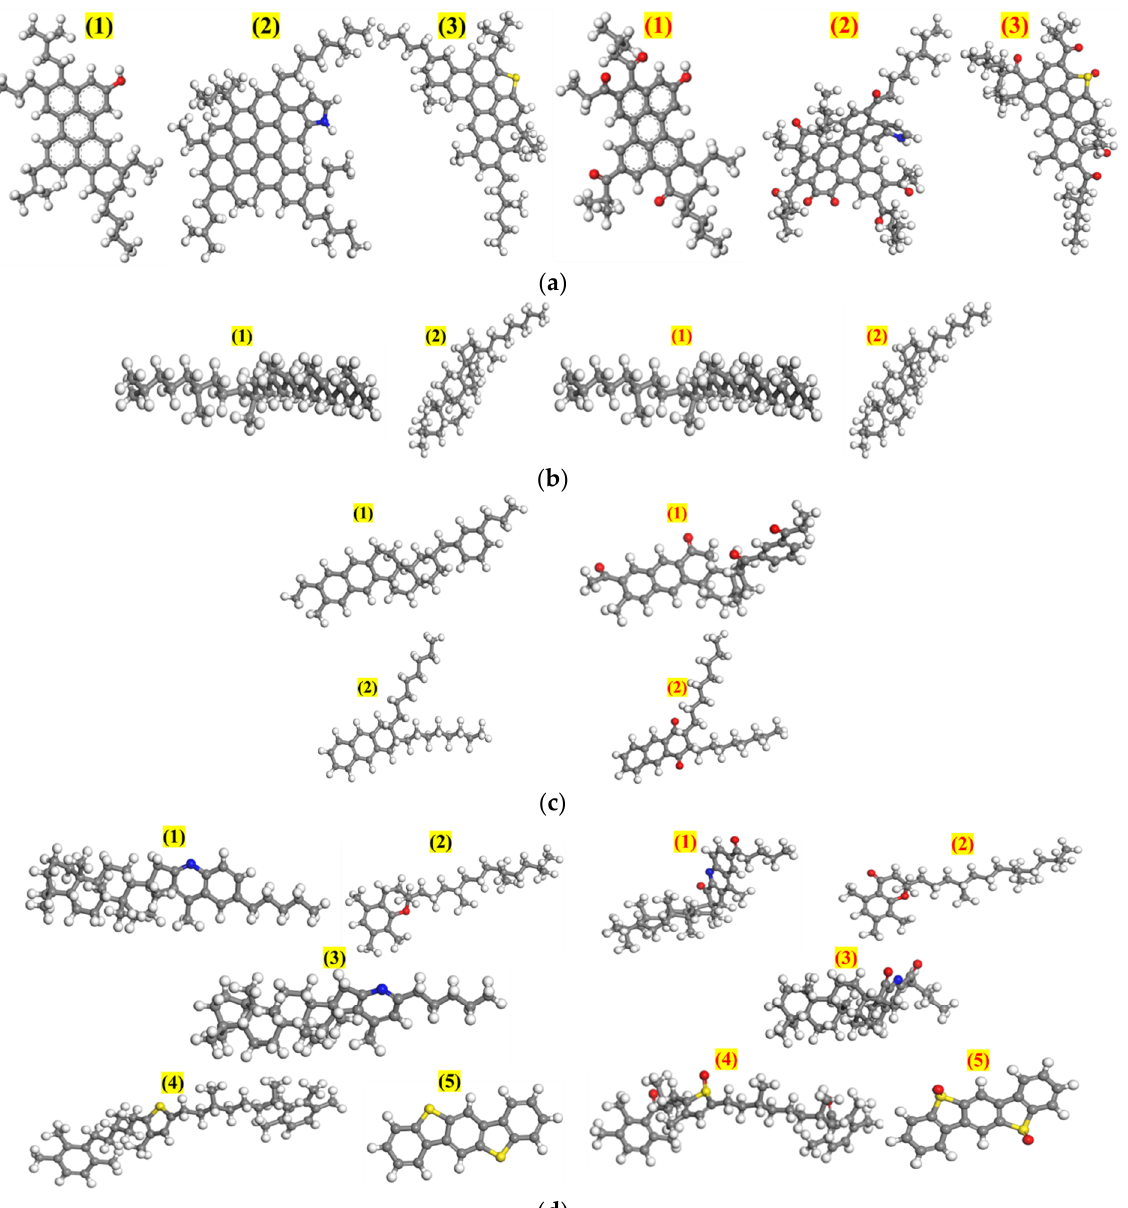
Figure 3. Molecular structures of base and aged asphalt SARA fraction. ( a ) Asphaltenes—As. ( b ) Saturates—Sa. ( c ) Aromatics—Ar. ( d ) Resins—RE. (Gray is carbon atom, white is hydrogen atom, blue is nitrogen atom, red is oxygen atom, and yellow is sulfur atom) (Black numbers represent BA components, and red numbers represent aged asphalt components). Table 3. Molecular composition of asphalt.